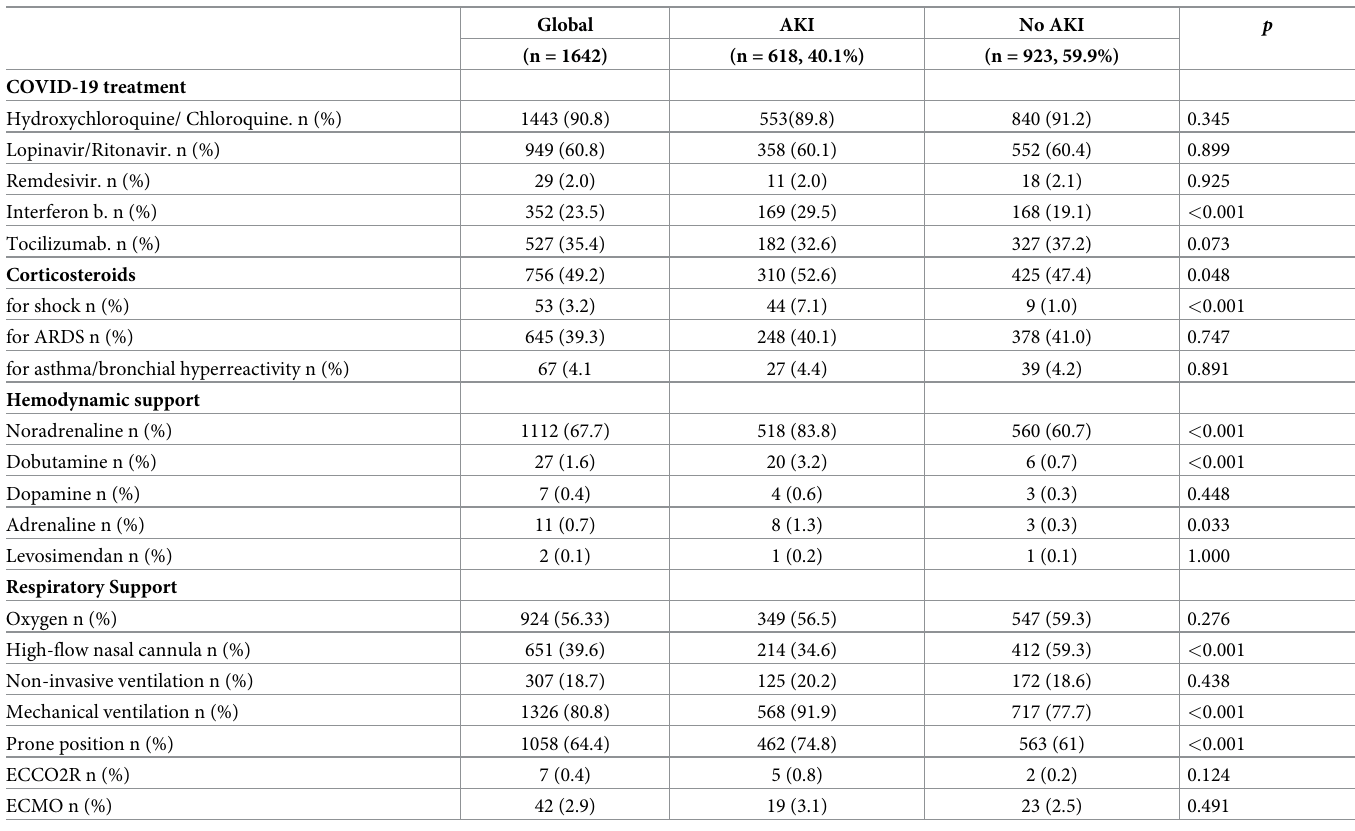
Table 3. Treatments and